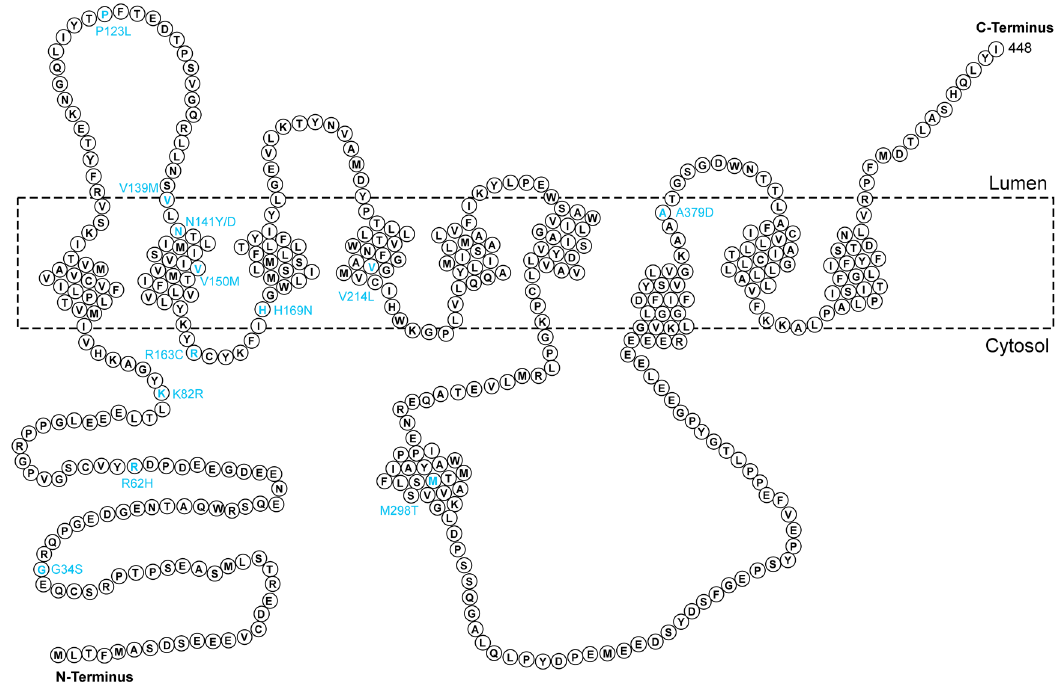
Figure 3. Amino acid sequence of presenilin 2 (PSEN2). The reported distribution of mutations in the Chinese population is labeled in cyan at the corresponding sites.